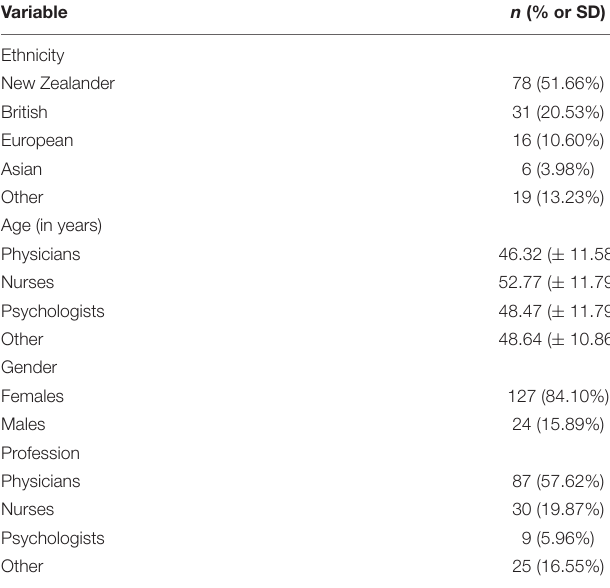
TABLE 1 | Demographic characteristics of the health professional